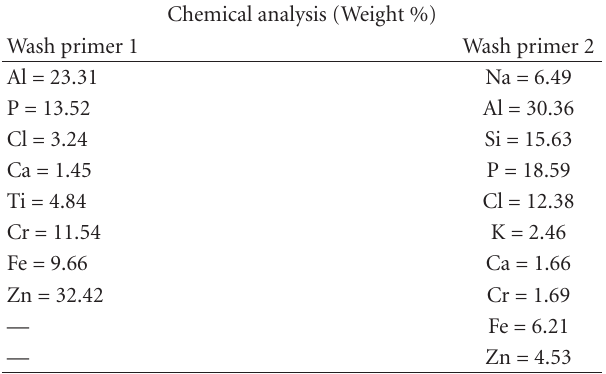
Table 4: Elemental analysis: wash primer sealer manufacturer 1 and 2.